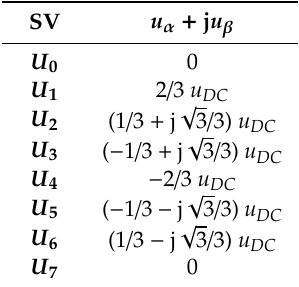
Table 2. SVs in the α - β coordinate